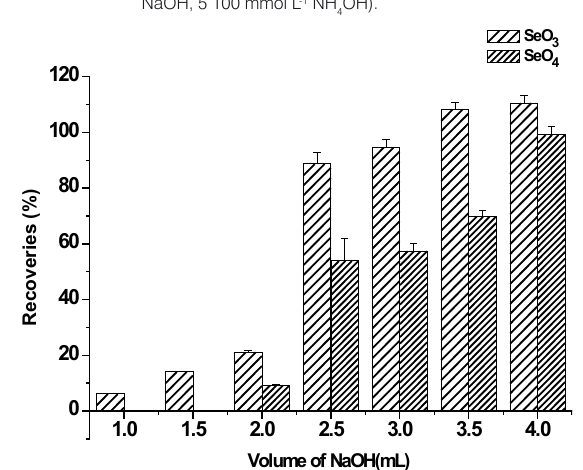
Figure 3. The effect of elute solution volume on